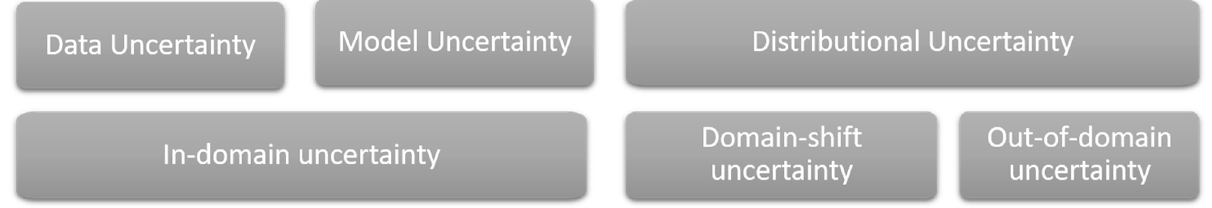
Figure 3. The Classi fi cation of the uncertainties of neural networks.